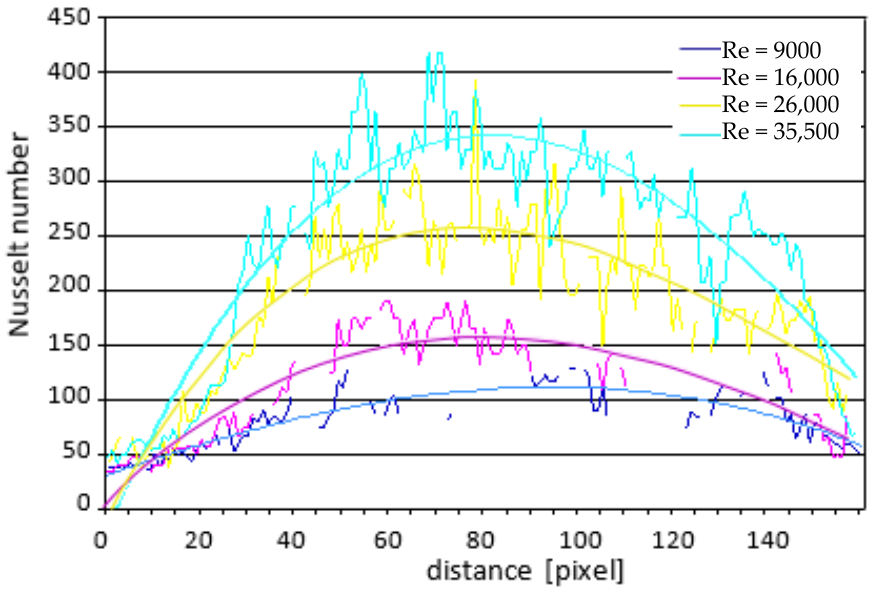
Figure 15. Local Nusselt numbers distribution for P/e = 11, configuration¬_4 and p4 mid-section.